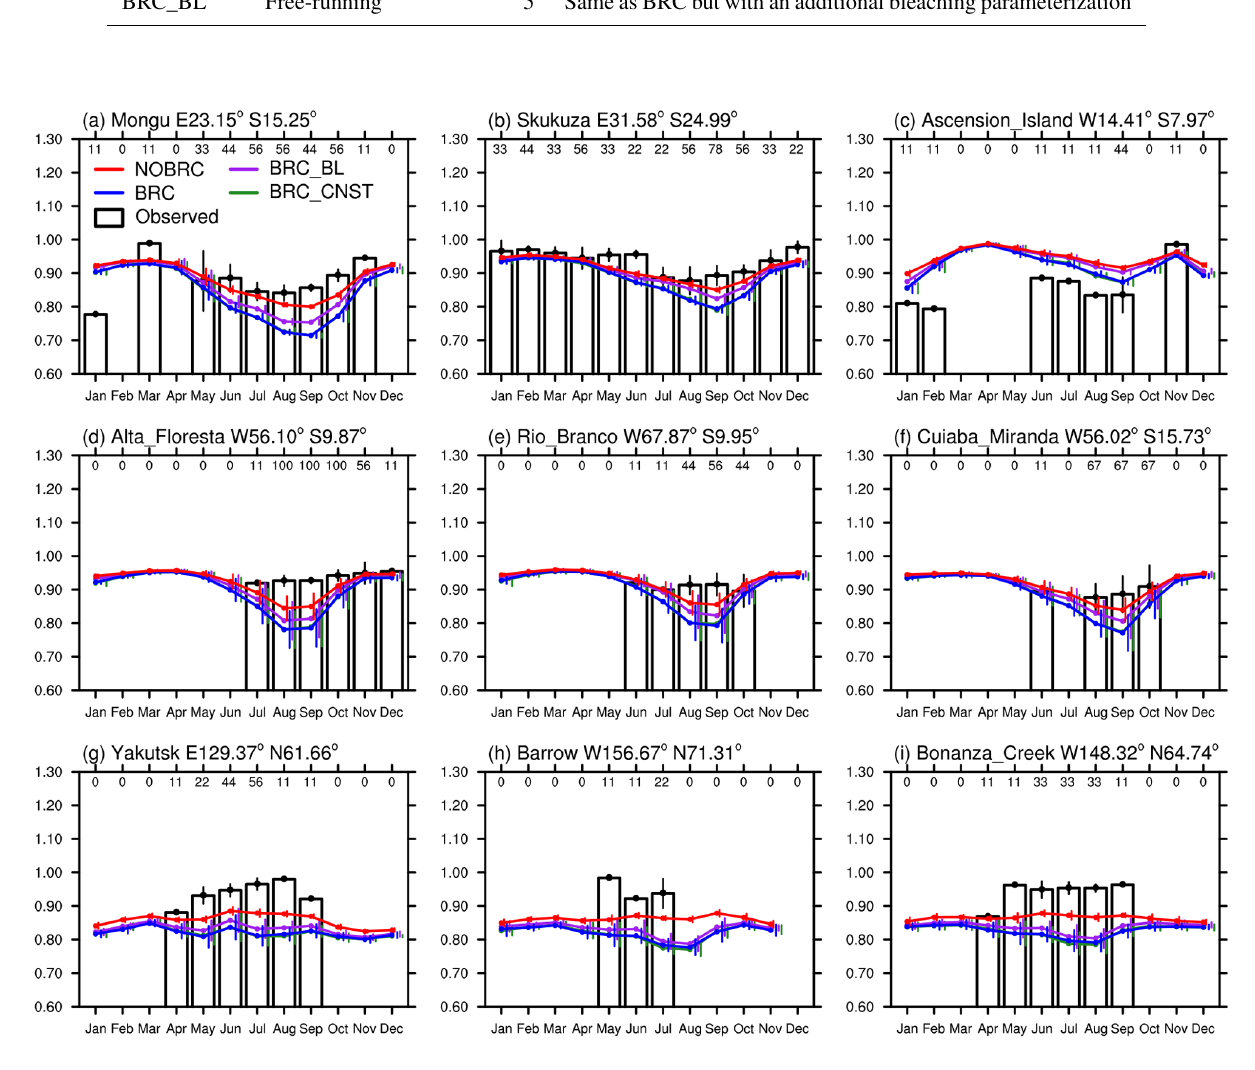
Figure 3. AERONET SSA compared to CAM5.4 model output SSA, not including brown carbon (NOBRC), including brown carbon (BRC, BRC_CNST), and including brown carbon and a bleaching effect (BRC_BL). Vertical lines are color-coded error bars and run from left to right as follows: observed, NOBRC, BRC, BRC_BL, and BRC_CNST. Values below the upper x axis indicate percentage of available data in the 9-year